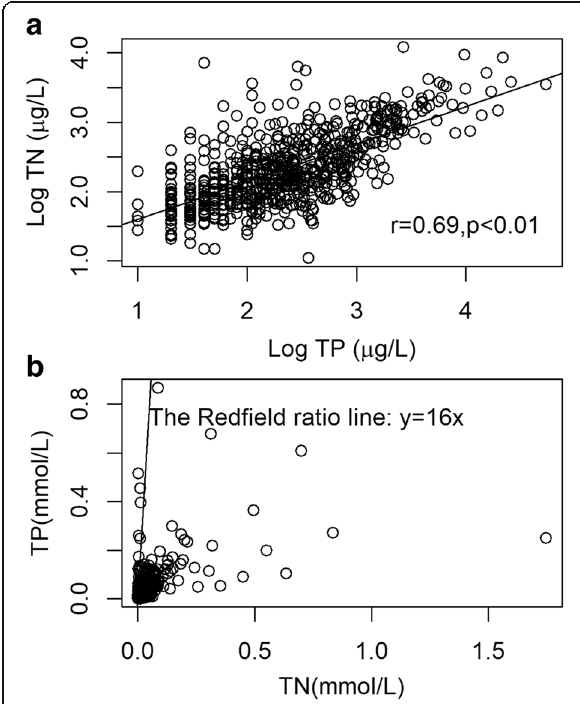
Fig. 2 The correlation between total nitrogen and total phosphorus at log scale ( a ) and the stoichiometric relationship ( b